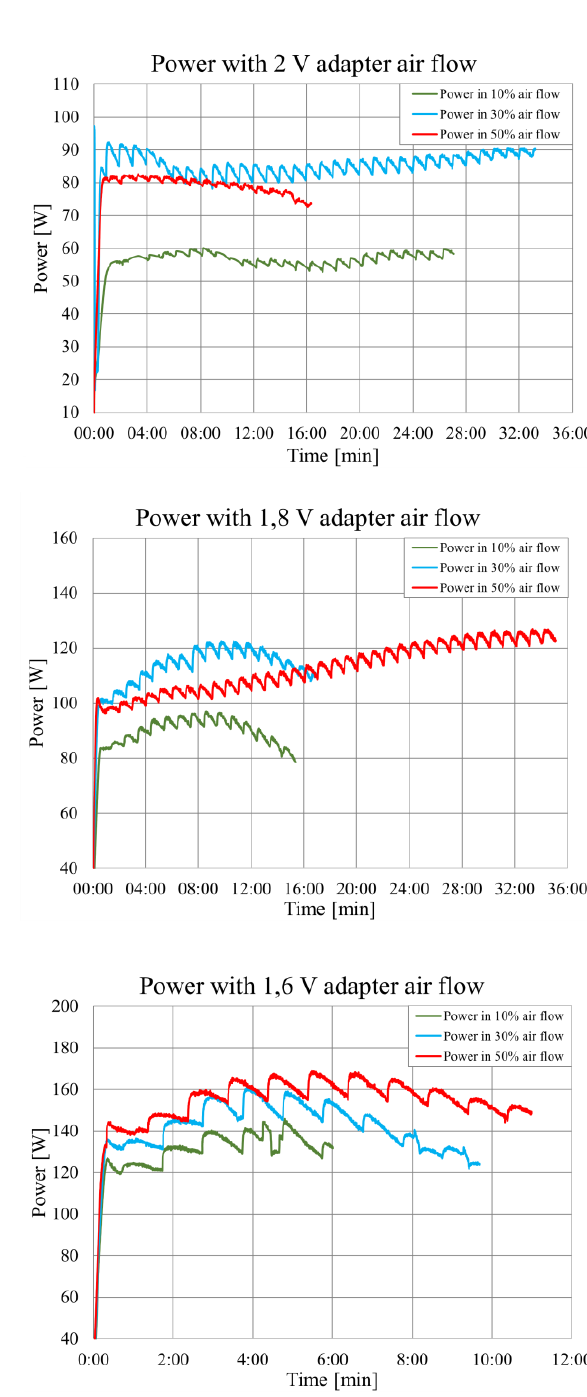
Fig. 4. Dependence of fuel cell performance on air flow and voltage - original adapter